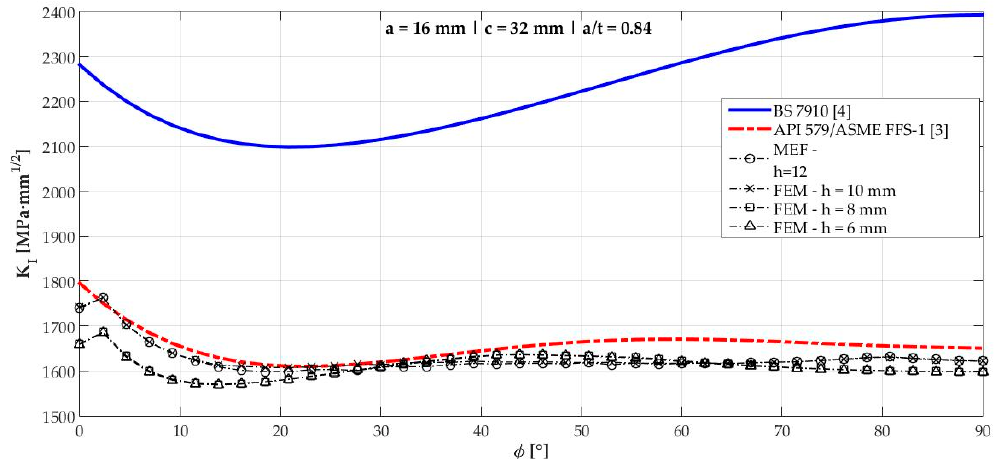
Figure 12. Mode I SIF profiles for crack 7 ( a = 16 mm , c = 32 mm , and a/t = 0.84 ).